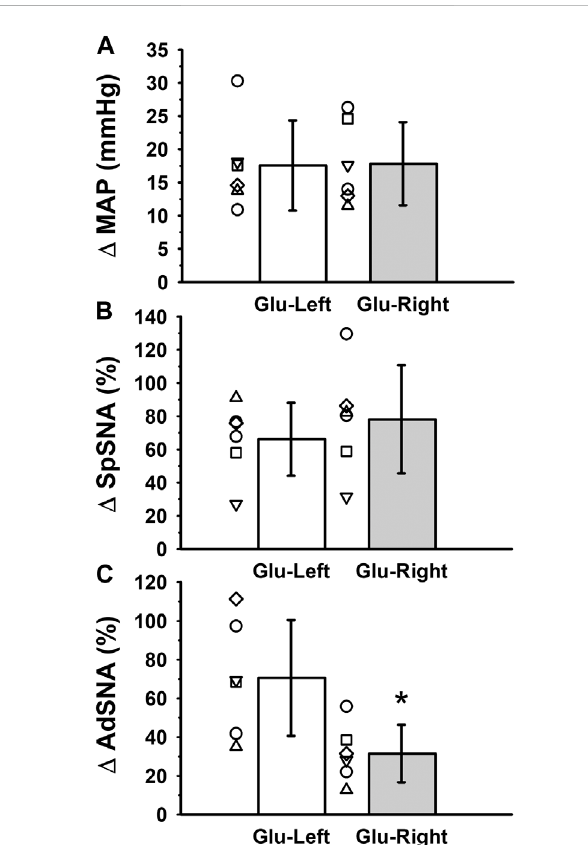
FIGURE 2 Group data from six experiments in which glutamate was microinjected into the left or right RVLM during simultaneous measurementsof (A) meanarterialpressure(MAP)and (B) leftSpSNAand (C) left AdSNA. Glutamate injections into either the right or left RVLM produced signi fi cant increases in MAP from baseline (Table 1; p < 0.001; main effect of glutamate), which when calculated as absolute change were not signi fi cantly different between left and right injections (Figure 2A; p = 0.942; paired t -test). Similarly, increases in SpSNA calculated as percent change were also not different between ipsilateral and contralateral injections (Figure 2B; p = 0.470; paired t -test), suggesting equivalent capacities of each RVLM to increase arterial blood pressure and SpSNA when activated by glutamatergic mechanisms. In contrast, increases in AdSNA calculated as percent change were signi fi cantly greater after ipsilateral compared to contralateral injections (Figure 2C; *, p = 0.017; paired t -test), suggesting a greater capacity of theipsilateralRVLMtoincreasesympatheticout fl owtotheadrenalgland via glutamatergic mechanisms. Abbreviations as de fi ned in Figure 1 legend.